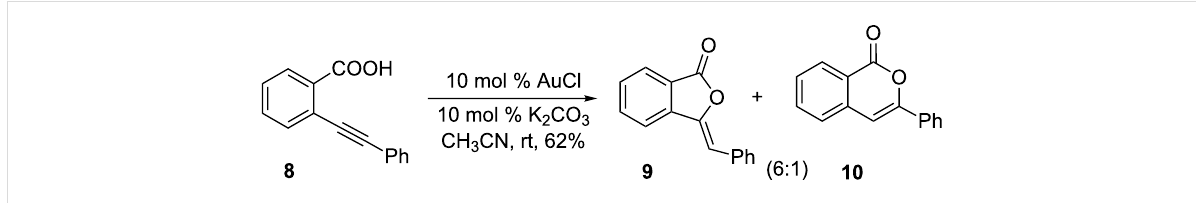
Scheme 1: Intramolecular gold(I)-catalyzed cyclization reaction of 8 to give 9 and 10 .